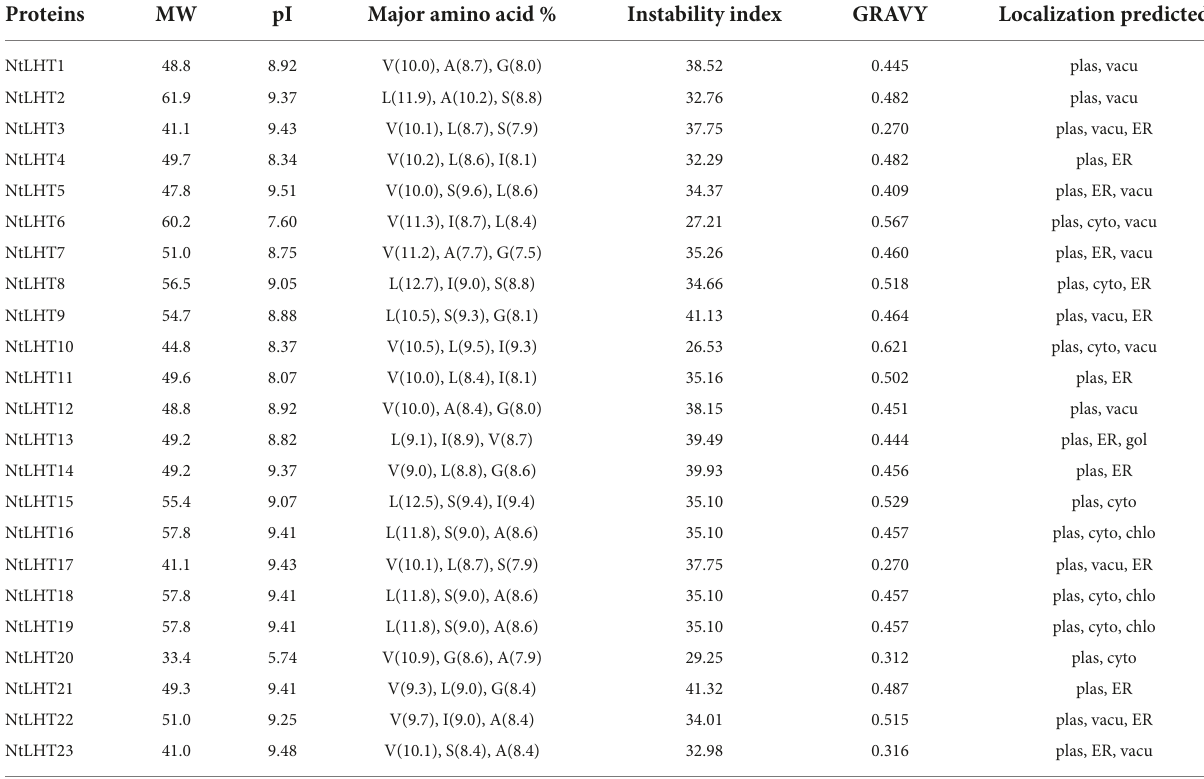
TABLE 2 Amino acid composition and physiochemical characteristics of NtLHT proteins. Proteins MW pI Major amino acid % Instability index GRAVY Localization